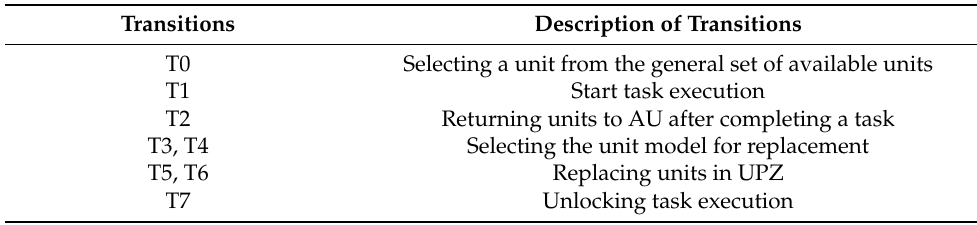
Figure 5. Structure of the ZExec module.